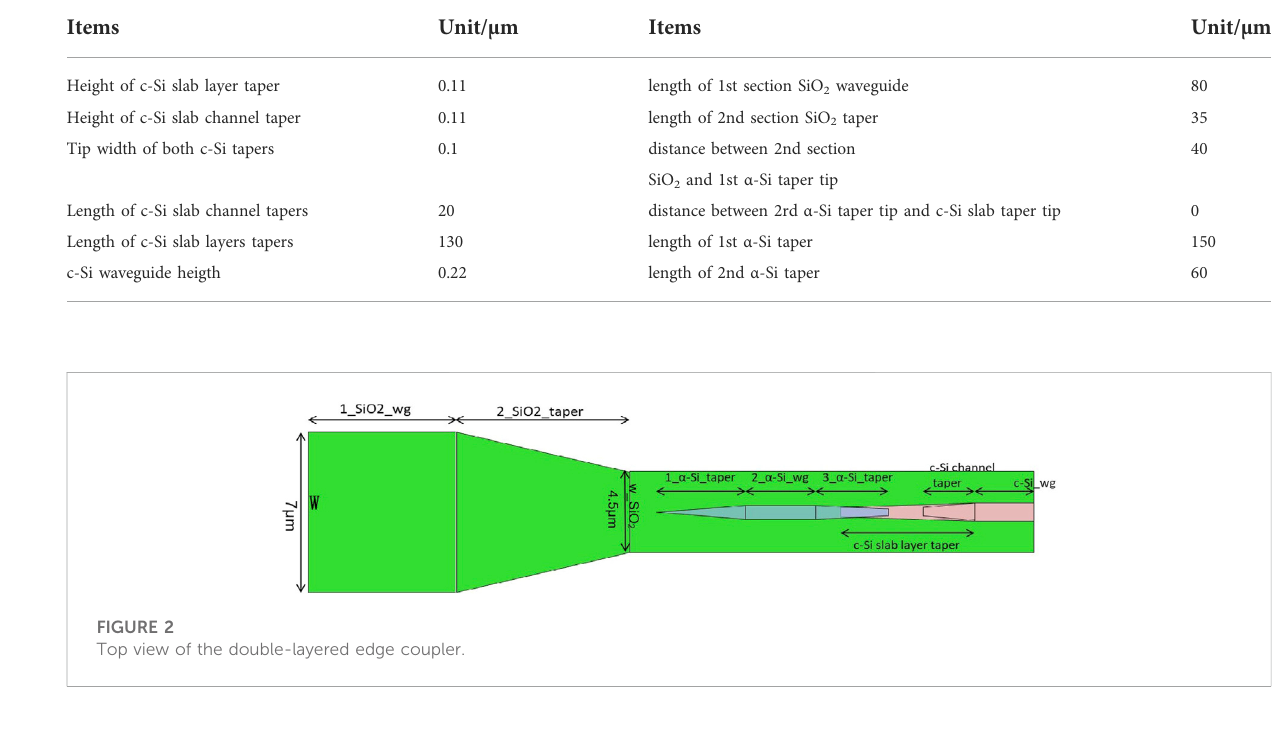
Figure 1B. SiO 2 waveguide facets are designed for the better mode matching with SMFs. To overcome the limitation of the fi nite BOX thickness, the α -Si layer is introduced on top of the c-Si waveguide SiO 2 layer. The optical signal from the optical fi ber is fi rst coupled into the suspended SiO 2 waveguide. Then,